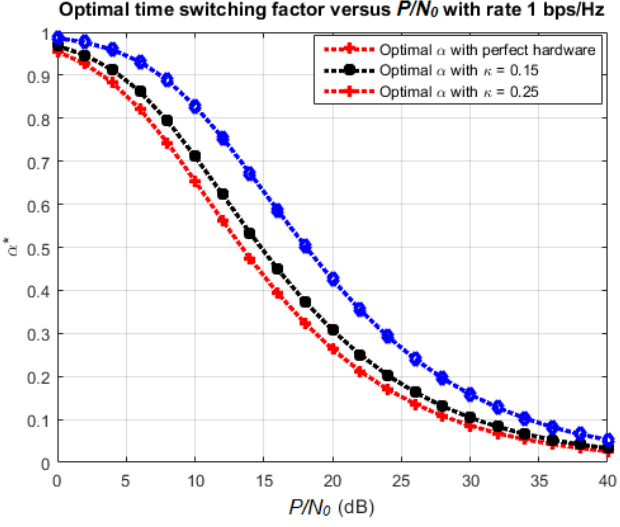
Figure 11. Effect of α and modulation scheme on